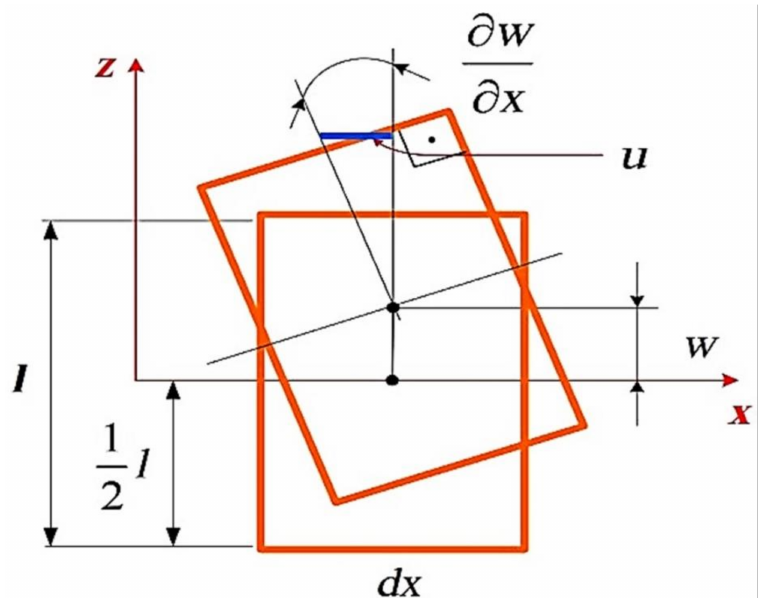
Figure 3. The explanation of the Kirchhoff-Love plate model. Where 1 is the plate thickness, u is the plate displacement amplitude, w is the difference between centers of deformed and non-deformed plate, δ w/ δ x is the strain due to the applied force on the element and dx is an infinitesimal element in the